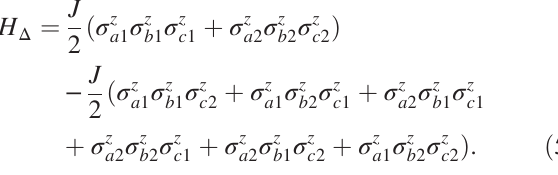
FIG. 2. Two sets of logical operators (right figure) that satisfy the commutation relations of four- dimensional generalized Pauli